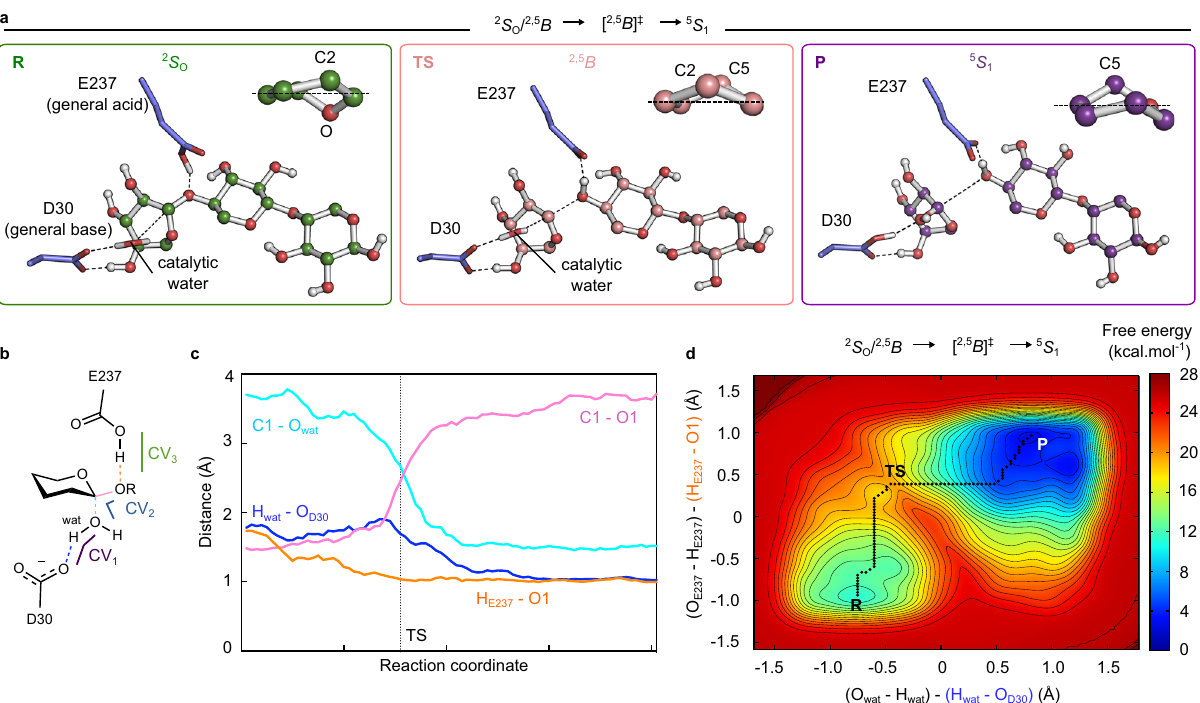
Fig. 7 The 2 S O / 2,5 B → [ 2,5 B ] ǂ → 5 S 1 catalytic itinerary. a Representative snapshots of the reactant (R), transition state (TS) and product (P) states of the catalytic itinerary . A zoom of the − 1 sugar conformation is represented at the top right of each state. b Schematic representation of catalytically relevant distances and collective variables (CV 1 , CV 2 , and CV 3 ) (wat = catalytic water). The CV 1 (purple) corresponds to the difference between O wat – H wat and H wat – O Asp30 distances. The CV 2 (blue) was taken as the difference between C1 xylosyl – O4 xylosyl and O wat – C1 xylosyl distances. The CV 3 (green) was taken as the difference between O Glu237 – H Glu237 and H Glu237 – O1 xylosyl distances. c Evolution of distances represented in b (running averages over fi ve data points) along the reaction pathway. The distance between H E237 – O1 is represented in orange, the distance between H wat – O D30 in blue, C1-O wat in cyan and the glycosidic bond (C1-O1) in pink. d FEL of the catalytic reaction starting from 2 S O / 2,5 B , projected into CV 1 ((O wat – H wat ) − (H wat – O Asp30 )) and CV 3 ((O Glu237 – H Glu237 ) − (H Glu237 – O1 xylosyl )). The corresponding 3D FEL is shown in Supplementary Fig. 9. The minimum free energy pathway is indicated with a black dashed line on the two-dimensional FEL. Isolines are at intervals of 1 kcal mol − 1 . Source data are provided as a source data fi